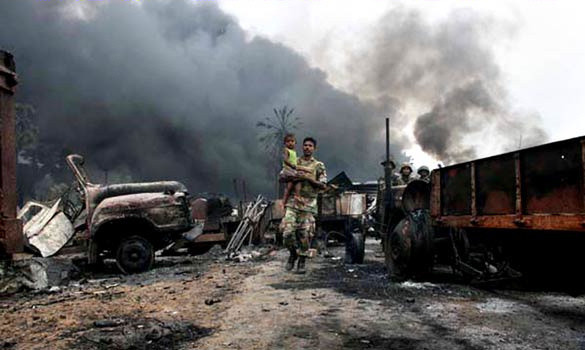
Apocalyptic Images [85].